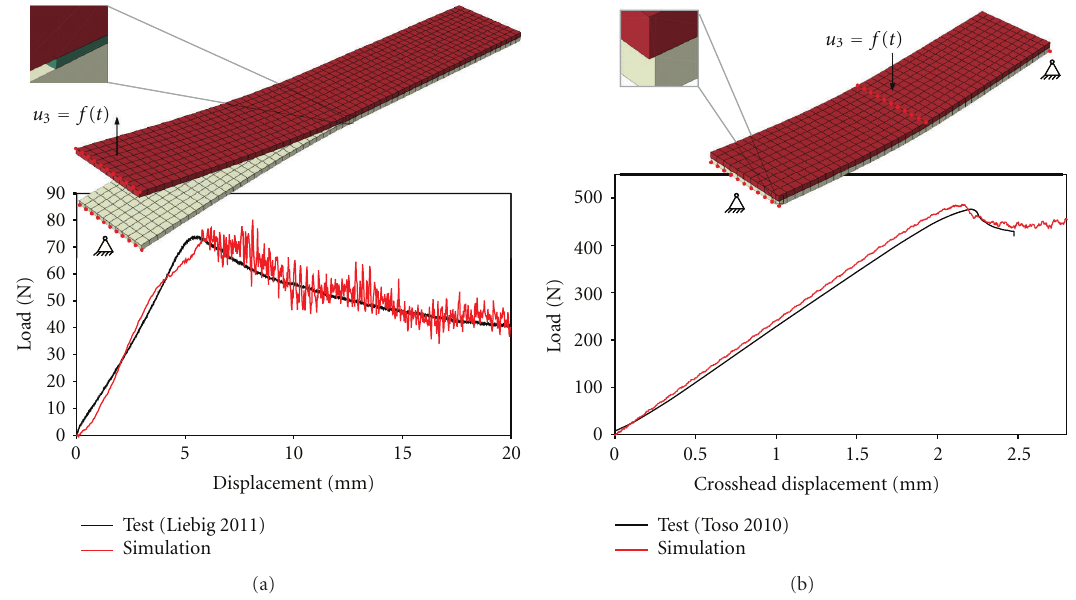
Figure 7: Validation of delamination model in simulations of (a) DCB and (b) ENF tests of T800S/M21